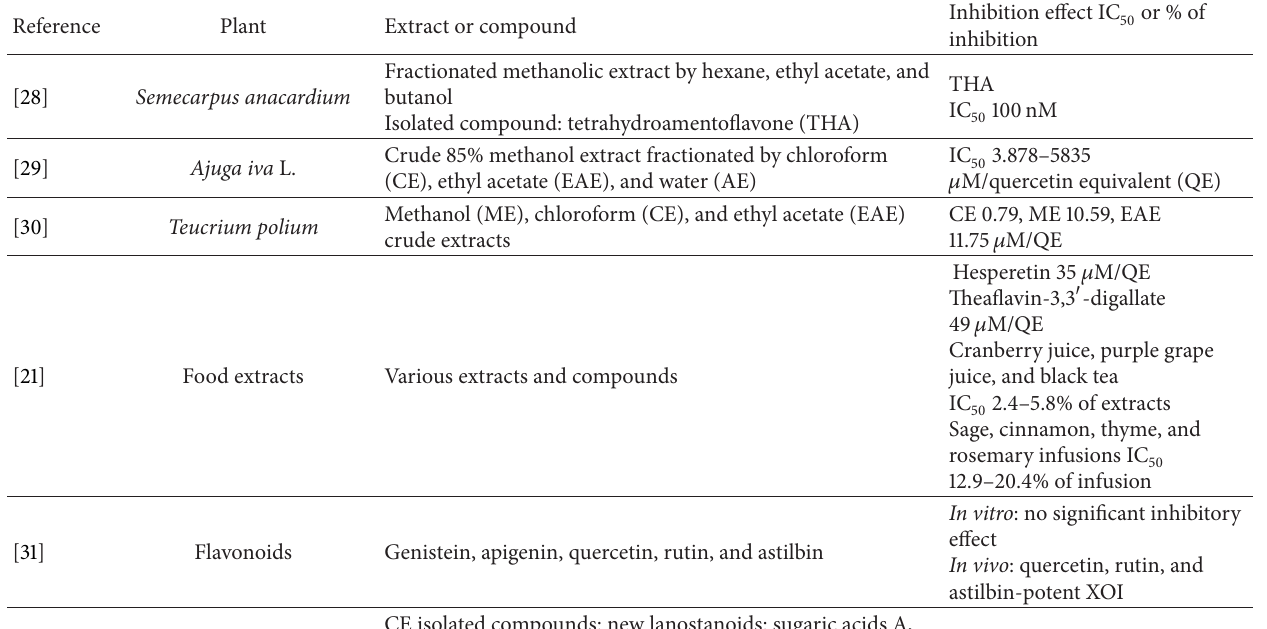
Table 2: Plant extract and pure compounds as potent